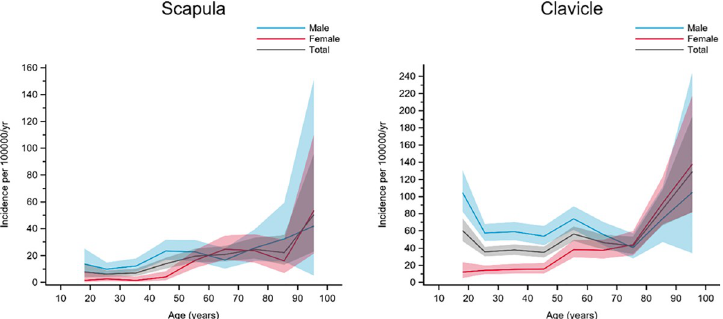
Fig 5. Fractures in group D. Age- and gender-specific incidence with 95% confidence interval. Black line represents the total population; red line represents females and blue line represents males.